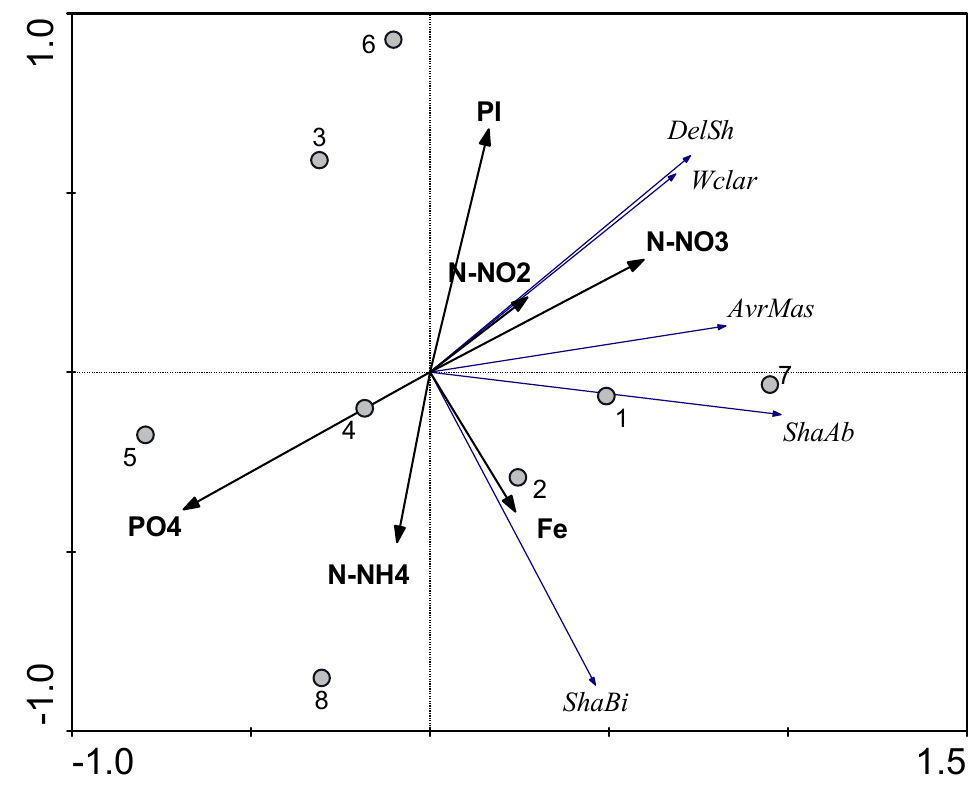
Figure 7. RDA ordination plot of environmental and structural variables of zooplankton of the Borovoe Lake, 2019. Abbreviations used in the figure: ShaBi − Shannon Bi, ShaAb − Shannon Ab,